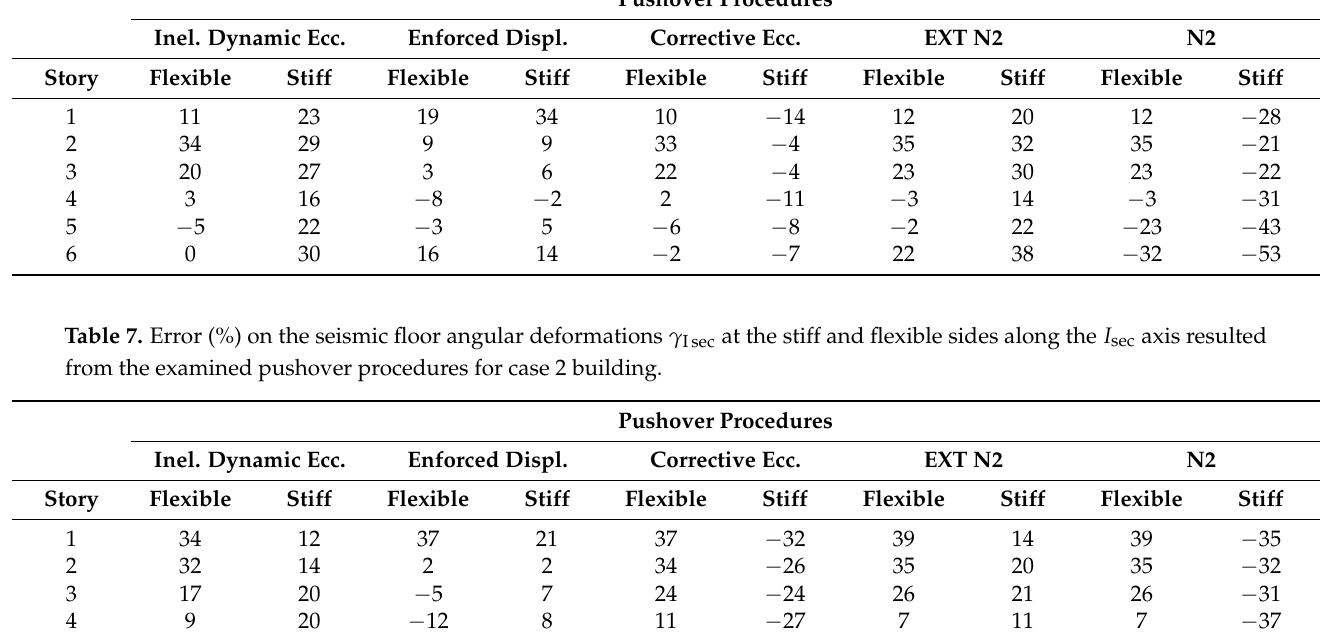
Table 6. Error (%) on the seismic floor angular deformations γ IIsec at the stiff and flexible sides along the II sec axis resulted from the examined pushover procedures for case 2 building. Pushover Procedures Inel. Dynamic Ecc.